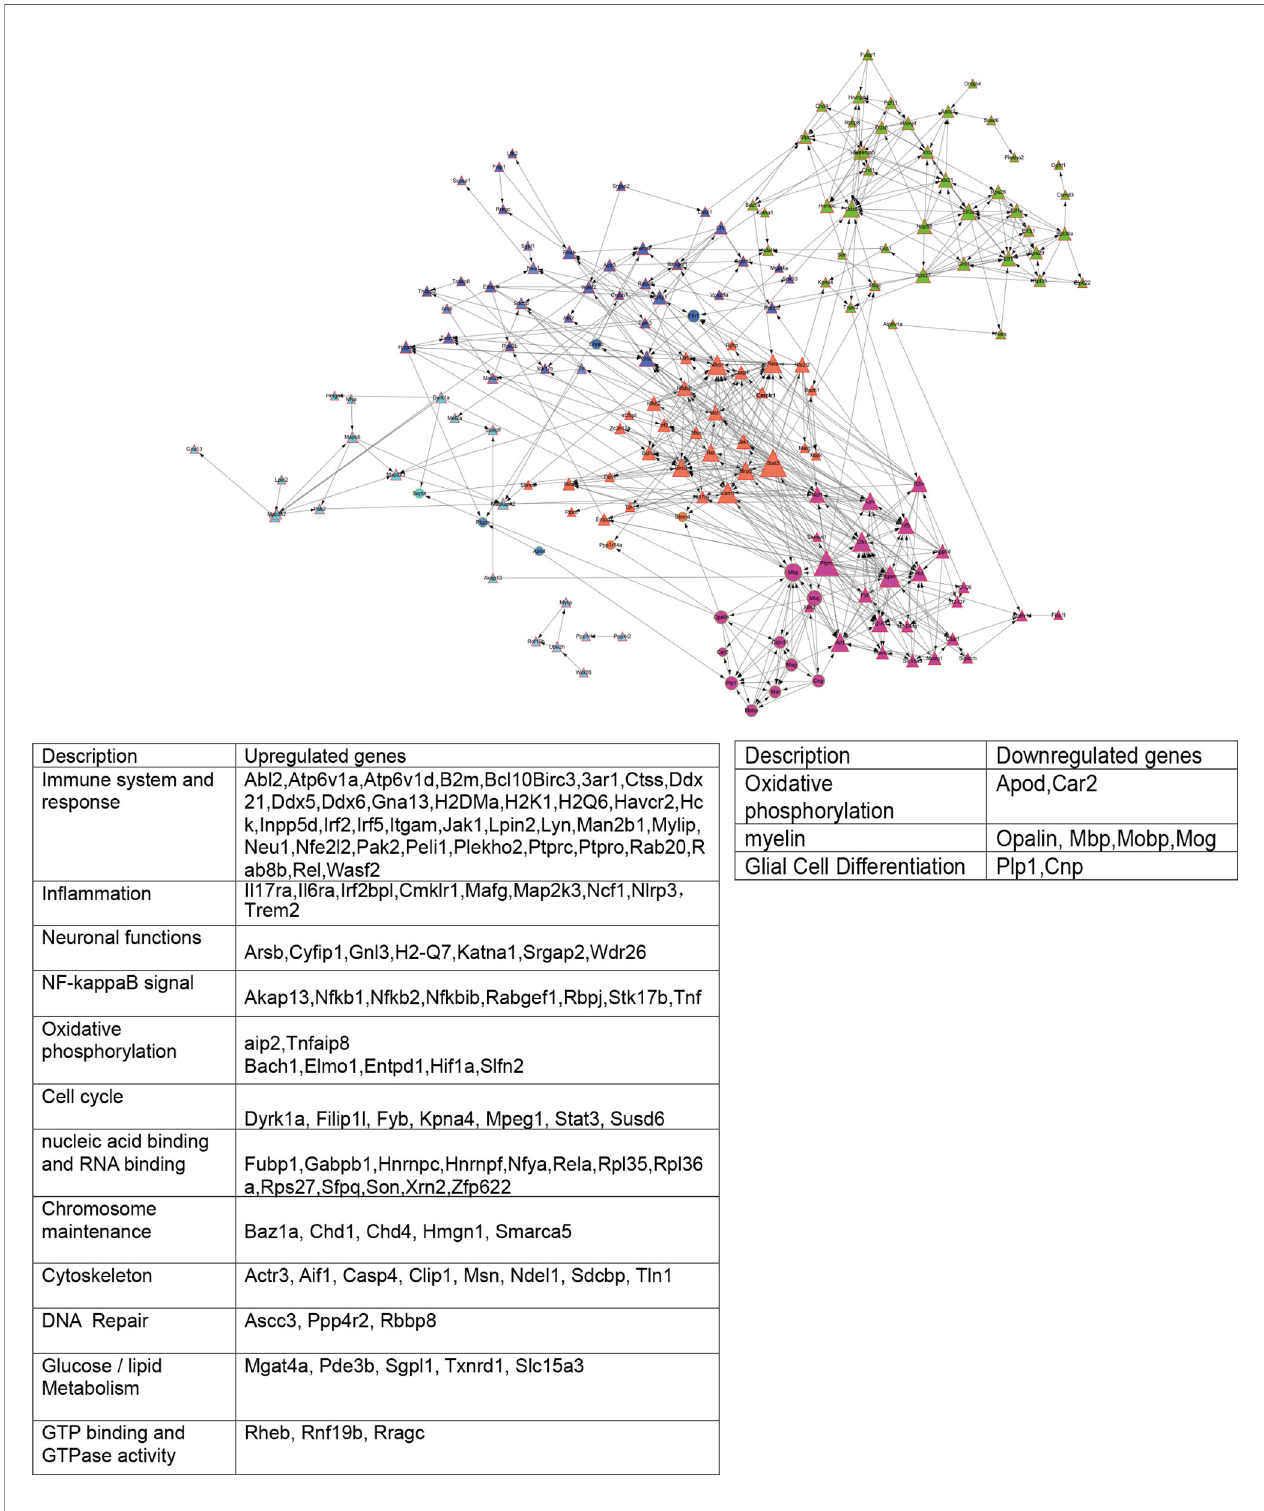
FIGURE 3 | STRING analysis of DEGs networks in db/db with db/m microglia. Shapes represent up - and downregulated messages. Triangles represent upregulated gene networks and circles represent downregulated gene networks; Different colors represent different cluster, the size of the dots represents the degree.